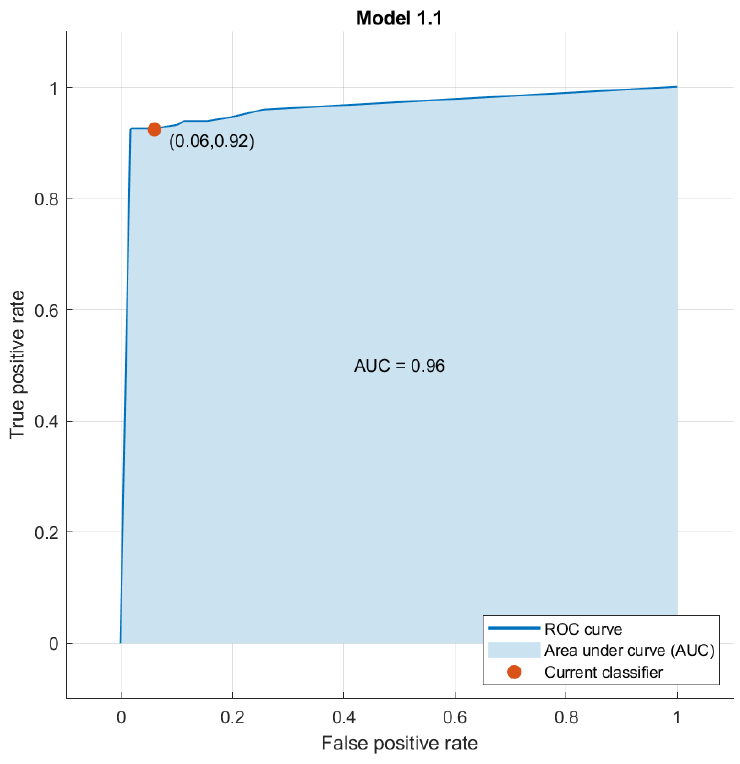
Figure 9. Confusion matrix after model training (2nd group of data; green – correct classification, red - misclassification) .